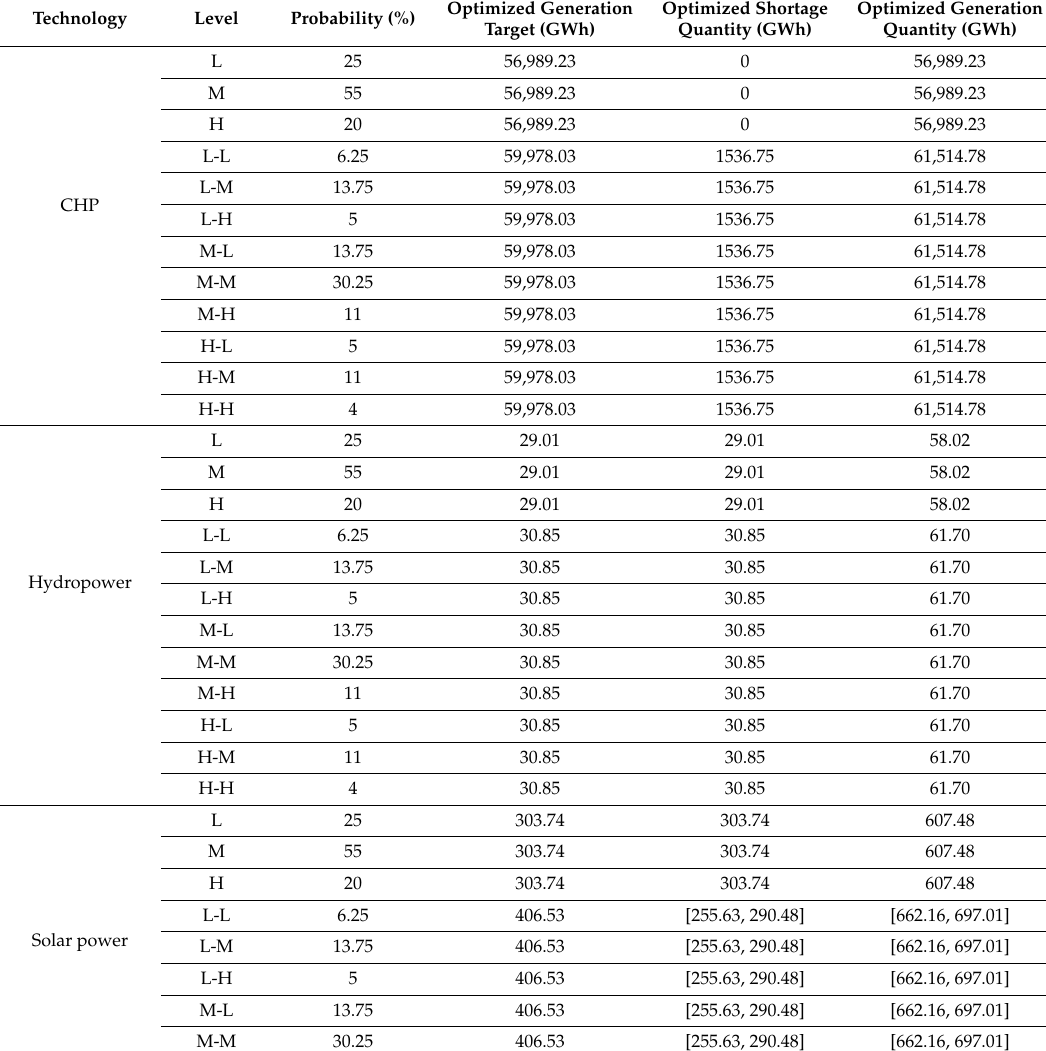
Table 3. The optimized power generation schemes under λ =